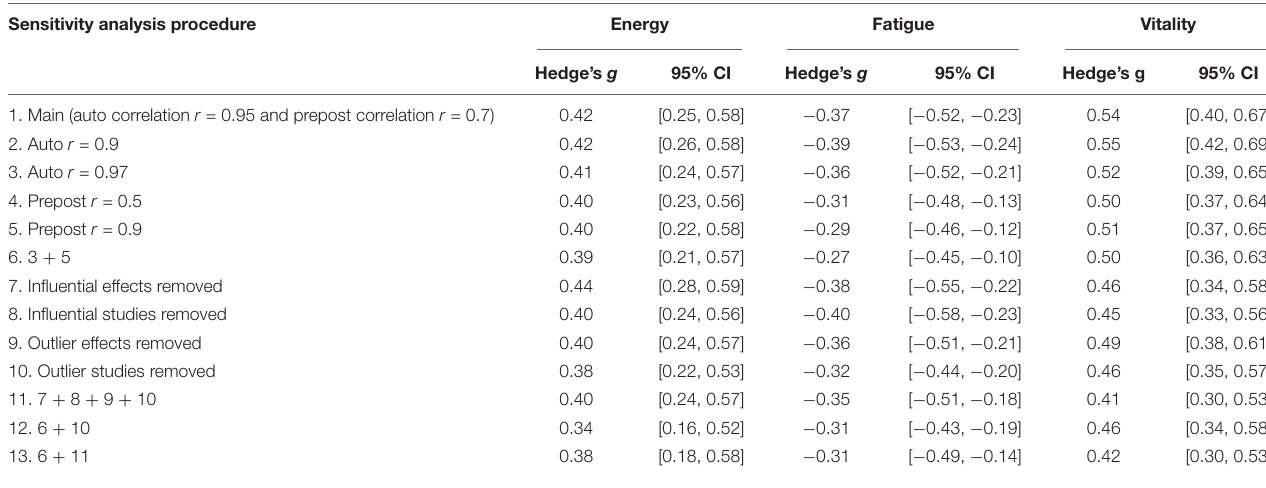
TABLE 1 | Sensitivity